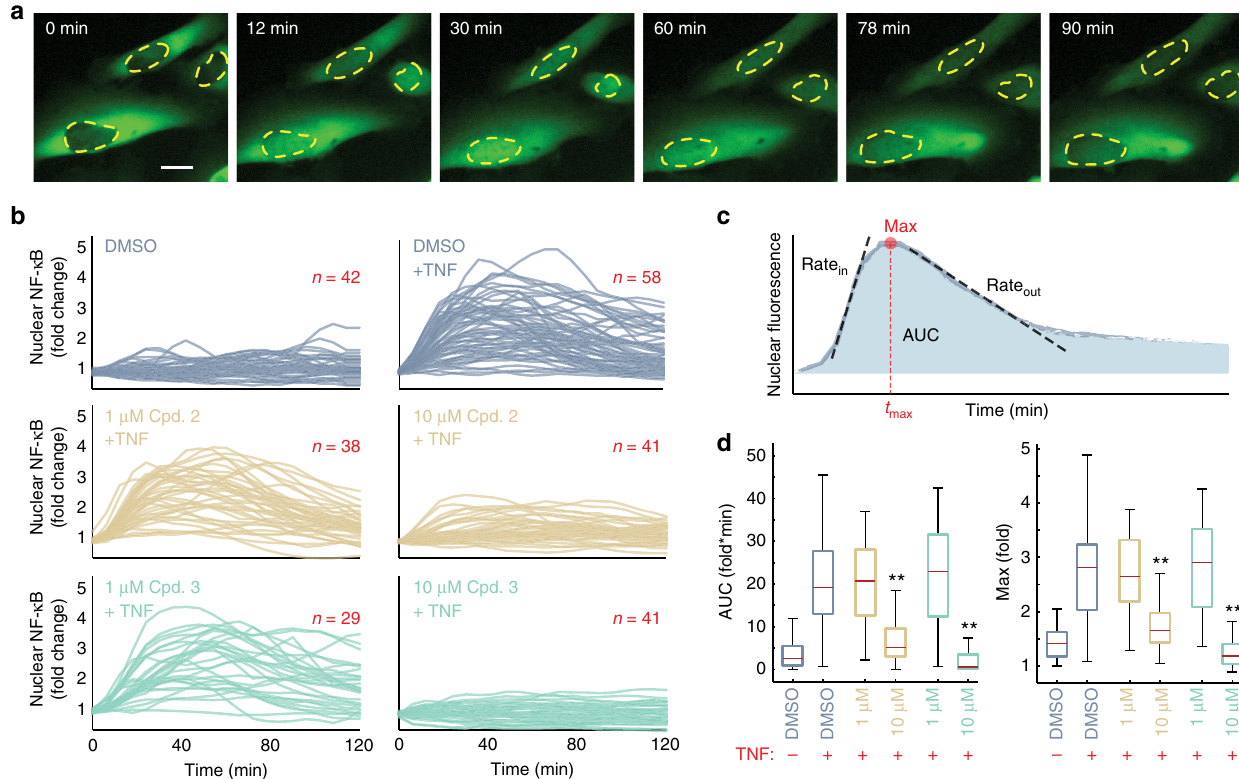
Fig. 3 Predicted disruptors of NF- κ B signaling reduce nuclear NF- κ B translocation in response to TNF. a Time-lapse images of fl uorescent protein (FP)-RelA expressed from its endogenous gene locus in U2OS cells exposed to TNF. The nuclear subcellular compartment is indicated with a broken yellow line. See also Supplementary Movie 1; Scale bar 20 µ m for all. b Single-cell time courses of nuclear FP-RelA measure the change in the nuclear abundance of NF- κ B in response to the indicated TNF conditions for cells pre-exposed to either dimethyl sulfoxide (blue lines), compound 2 (tan lines), or compound 3 (teal lines). Red numbers indicate the number of single-cell trajectories in each condition. c Descriptors used to quantify single-cell responses. AUC, Max, and t fl uorescence. Rate max , respectively, describe the area under the curve, the maximum, and the time of maximal nuclear FP-RelA in and Rate out describe the maximal rate of nuclear entry and exit. d Box ( fi rst and third quartile) and whisker (1.5 times interquartile range) plots showing the condition-speci fi c variation for descriptors of nuclear FP-RelA localization. Indicated conditions and the number of single-cell time courses measured from b for each descriptor. Red center line indicate the median; red minus and plus symbols, respectively, indicate the absence or presence of TNF; double stars indicate p value <10 − 6 (two-tailed), based on permutation test (Supplementary Fig. 7). Source data are provided as a Source Data fi